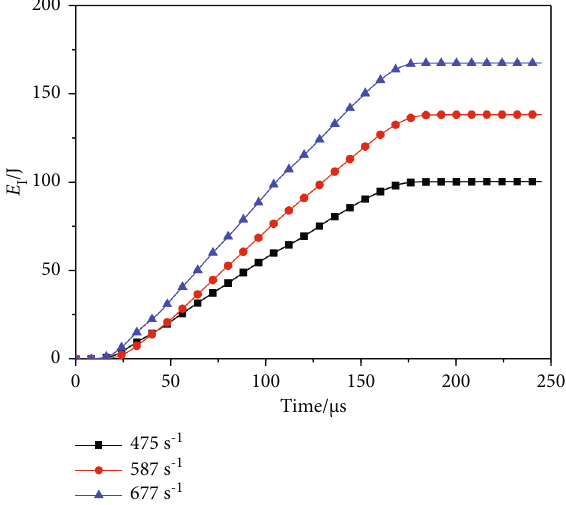
Figure 5: The incident energy curves with various strain